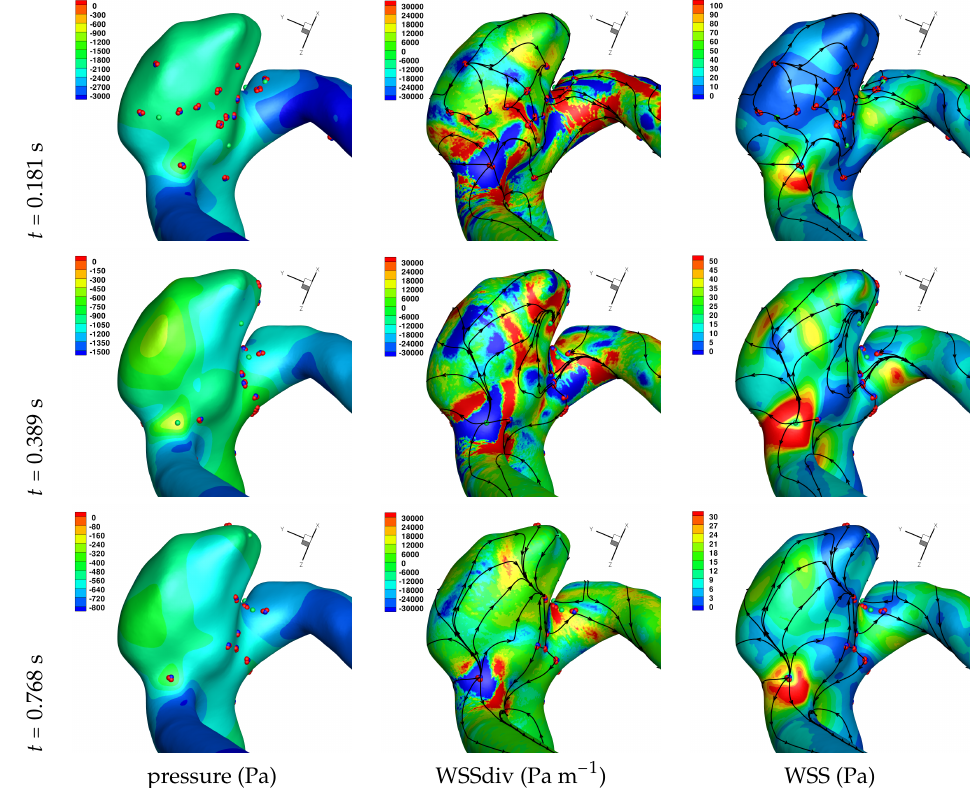
Figure 7. Solution for Case 4. Plots of surface shear lines and WSS critical points (colouring scheme as in Figure